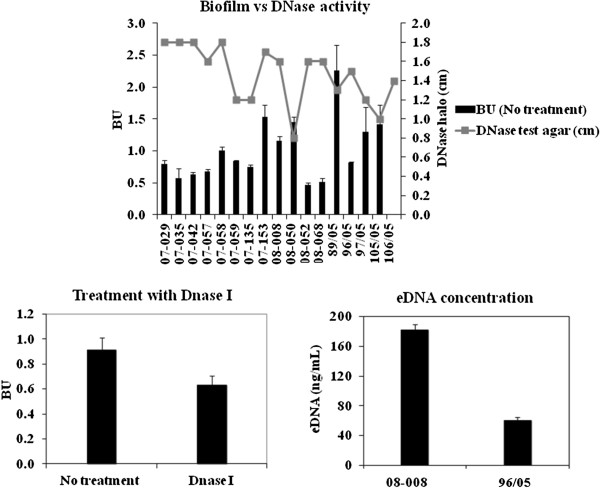
Bacterial DNase activity, treatment of the biofilm with DNase I and eDNA assay. Top: DNase activity was detected in culture supernatants of 16 ST1 isolates by measuring the halo size (cm) produced on Difco™ DNase Test Agar (BD). BU: Biofilm values for 16 ST1 isolates using inert polystyrene. Left bottom: For 16 ST1 isolates, 56U/well of DNase I were added to the culture media and the amount of biofilm accumulated determined. Right bottom: The concentration of eDNA determined in the biofilm supernatant. Isolate 08–008 (strong biofilm producer, agr-dysfunctional), 96/05 (moderate biofilm producer, agr-functional).